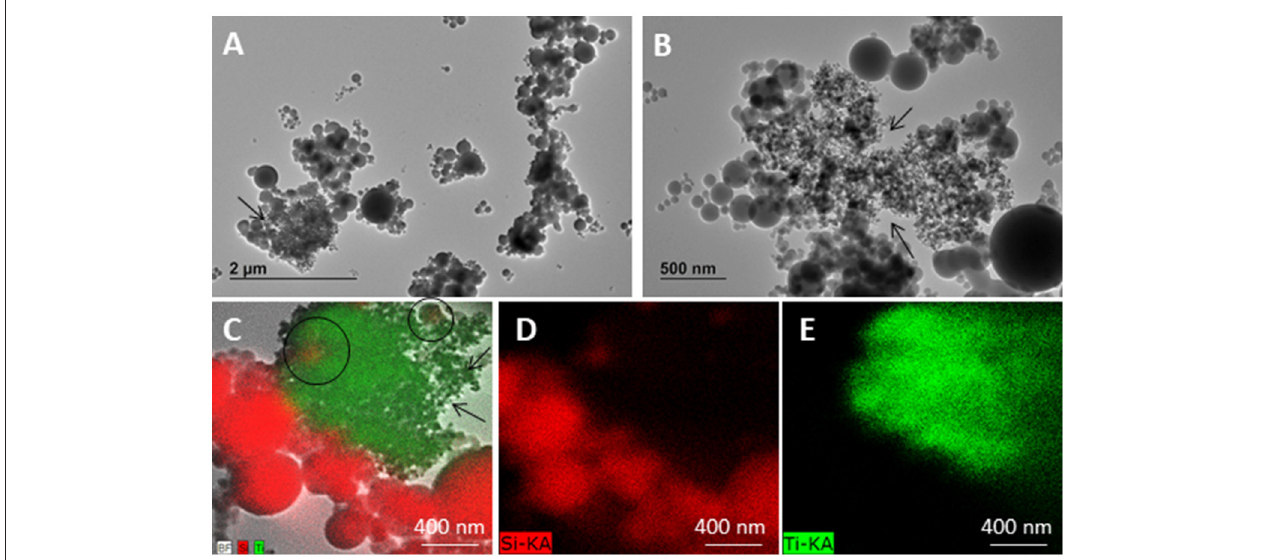
FIGURE 5 | TEM (120 kV) images of SUNSPACE sample exposed to JRCNM1005a titanium dioxide nanoparticles (arrows) (A,B) . Elemental analysis in STEM mode at 120 kV (C–E) . Titanium dioxide nanoparticles (green) interact and are co-localized (circle) with SUNSPACE material (silicium, red) only.